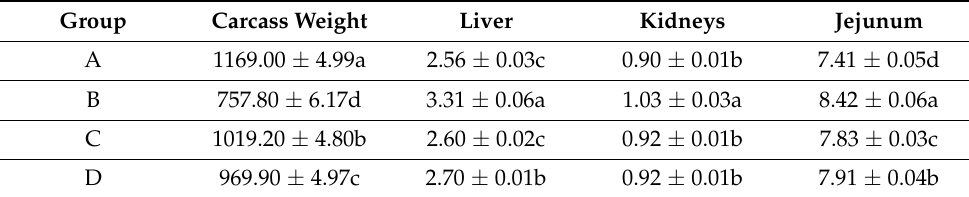
Table 5. Relative weight of various organs (g) in 2nd killing (Mean ± SD).